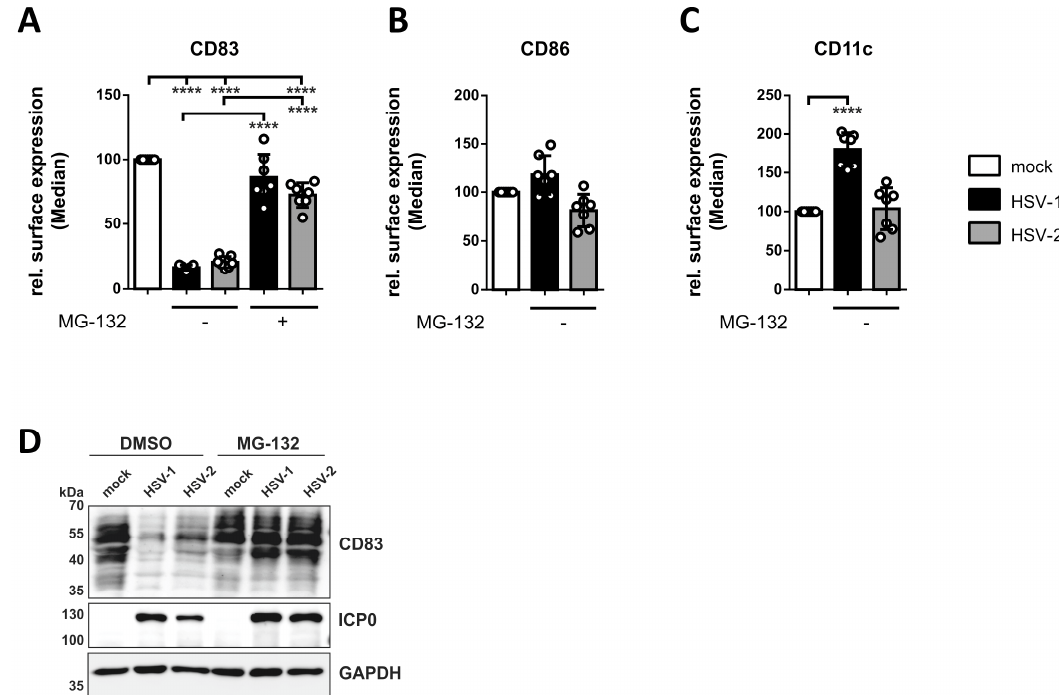
Figure 3. Loss of CD83 expression on / in HSV-2-infected mature DCs (mDCs). Mature DCs were mock-, HSV-1- (MOI of 2), or HSV-2-infected (MOI of 5) and treated with 10 µ M MG-132 at 1 hpi, or DMSO as control. DCs were harvested 16 hpi and ( A – C ) subjected to flow cytometric or ( D ) Western blot analyses. ( A – C ) The cells were stained with specific fluorochrome-labeled antibodies directed against ( A ) CD83, ( B ) CD86, and ( C ) CD11c. Median values are shown as percentages relative to mock-treated DCs. The experiment was performed seven times with cells from di ff erent healthy donors. Error bars indicate ± SD. Significant changes (**** = p < 0.0001) are marked by asterisks. ( D ) Protein lysates were prepared and equal amounts were loaded on a 12% acrylamide SDS-gel, which was subjected to Western blotting. Protein levels of CD83, HSV-1 / 2 immediate early protein ICP0, and GAPDH were detected. Representative data out of four experiments are